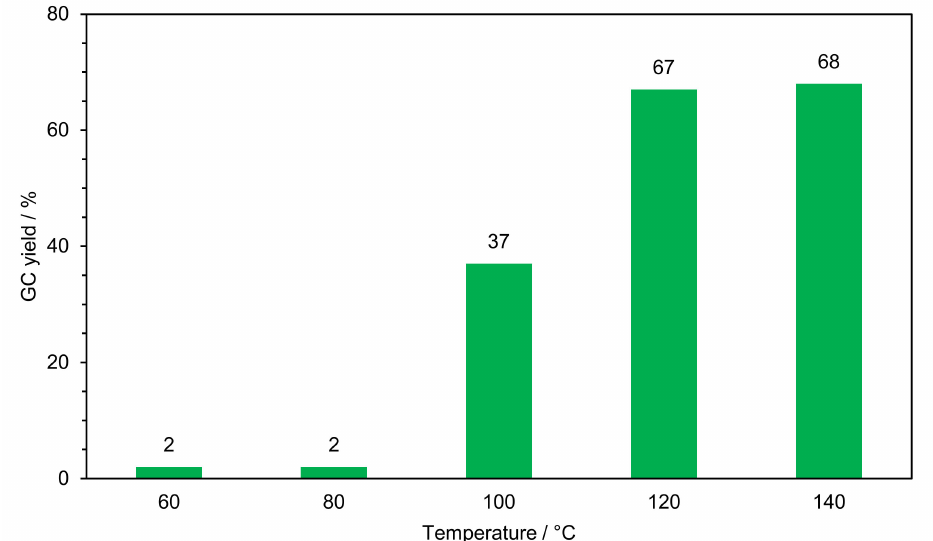
Figure 6. Effect of the reaction temperature on the product yield. Reaction conditions: 1,1- diphenylethylene (0.3 mmol); THF (1 mL); KI (20 mol%); DTBP (4 equiv.); Cu 1 Ce 0.7 Si catalyst (5.6 mg); under air for 20